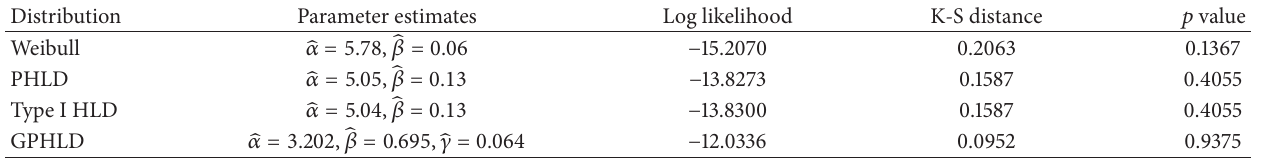
Table 6: Fitting based on data set